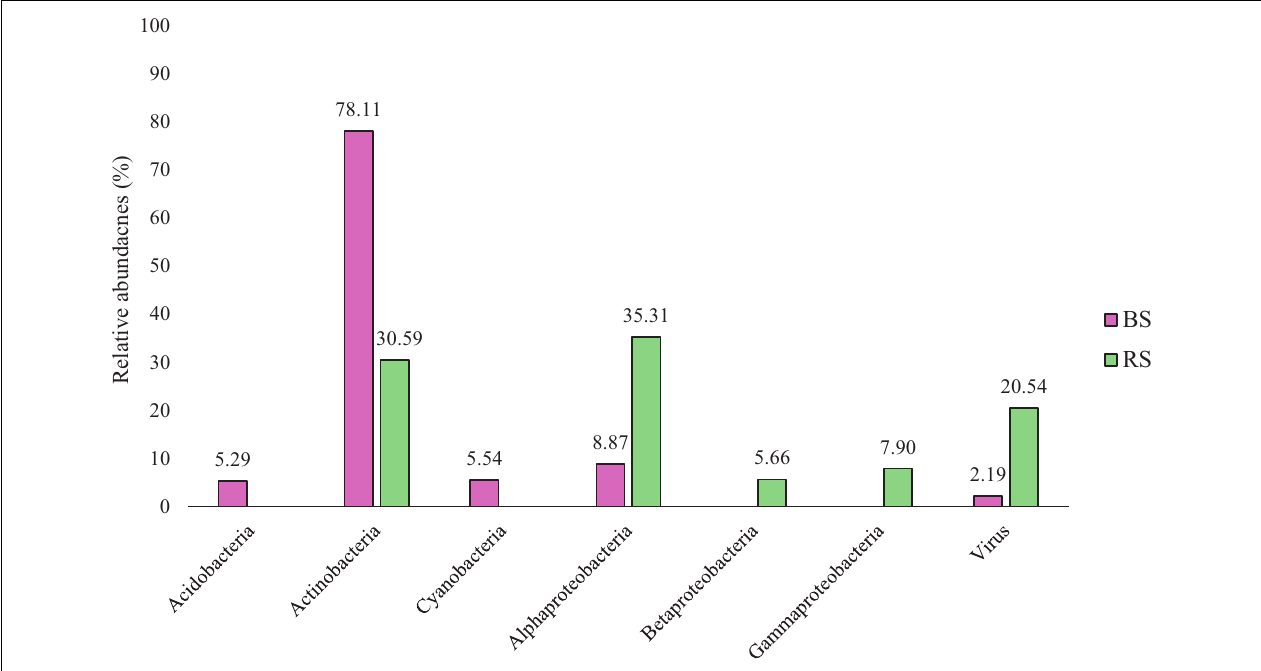
FIGURE 1 | Comparative of the Relative abundances by taxonomic level of Class in BS (Pink - Bulk Soil) and RS (Green - Rhizospheric Soil). Data in the figure show how the relative abundances of the diferent classes are further grouped according to their presence in RS or BS.